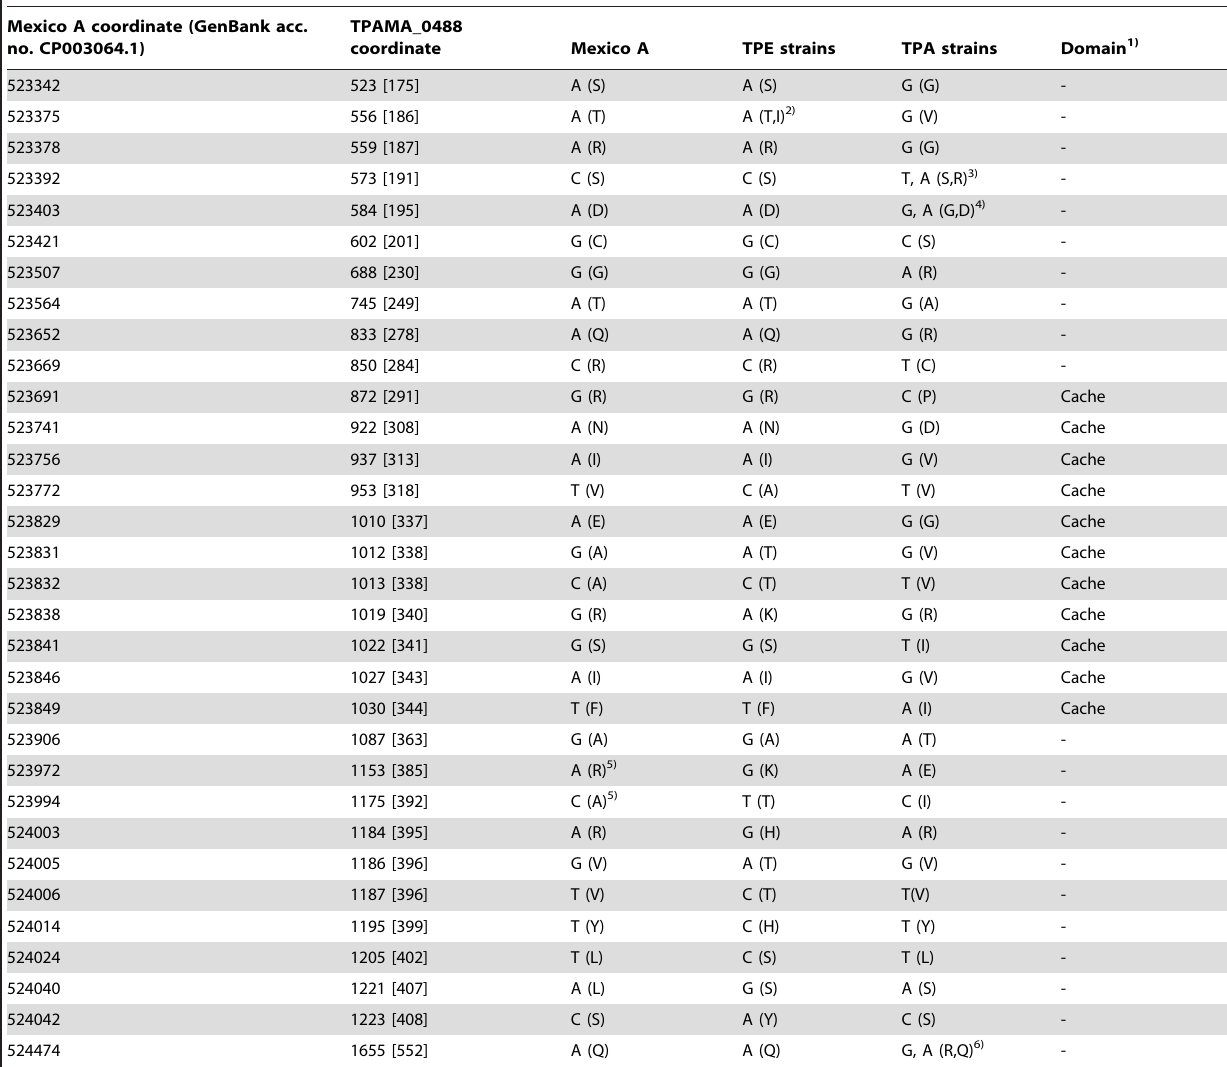
Table 2. A list of changes found at the TPAMA_0488 locus.